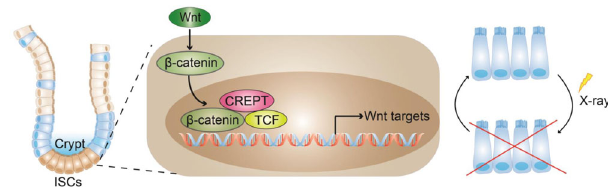
Fig. 7 A graphical model of CREPT function in ISCs and intestinal regeneration. ISCs reside in intestinal crypts. CREPT maintains the proliferation and differentiation of Lgr5 + ISCs at homeostasis. Under damages such as irradiation, CREPT promotes the activation of the Wnt signaling pathway through facilitating β -catenin retention in the nucleus. CREPT is indispensable for intestinal regeneration, and the deletion of CREPT leads to impaired proliferation ability of ISCs and failure of intestinal